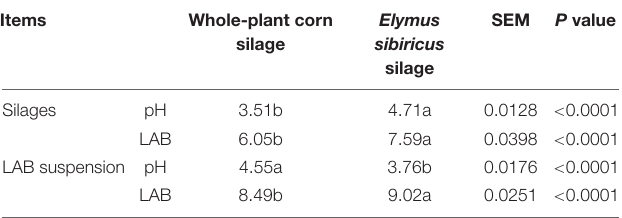
TABLE 1 | pH and lactic acid bacteria (LAB) counts of whole-plant corn silage and Elymus sibiricus silage (log 10 colony-forming units/g fresh weight), and of LAB suspension (log 10 colony-forming units/ml) prepared from the two silages.